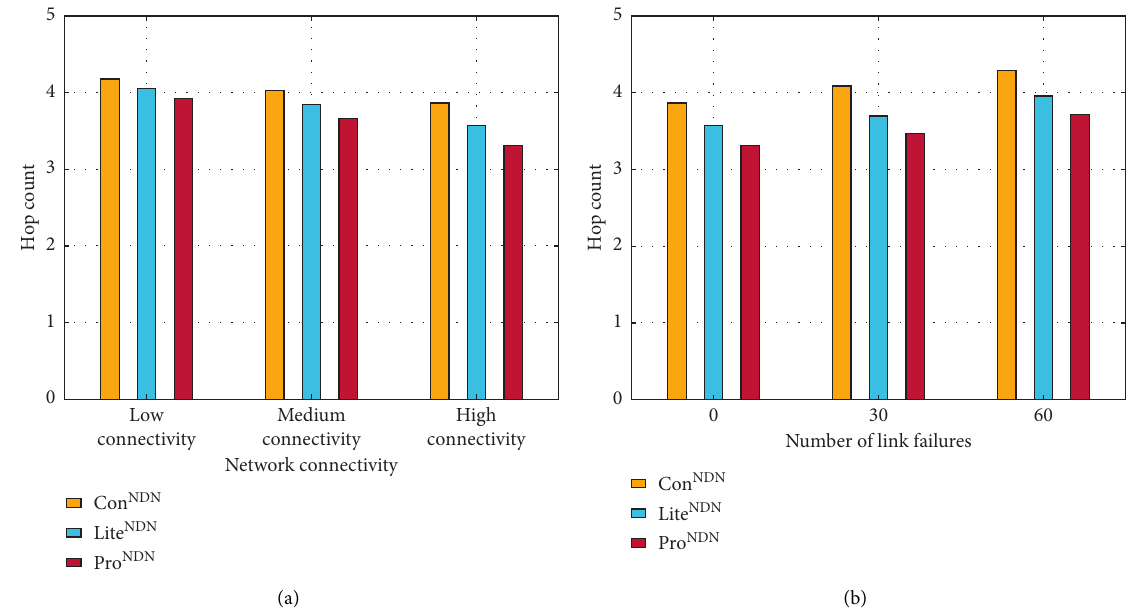
Figure 7: The performance of hop count against network connectivity and number of link